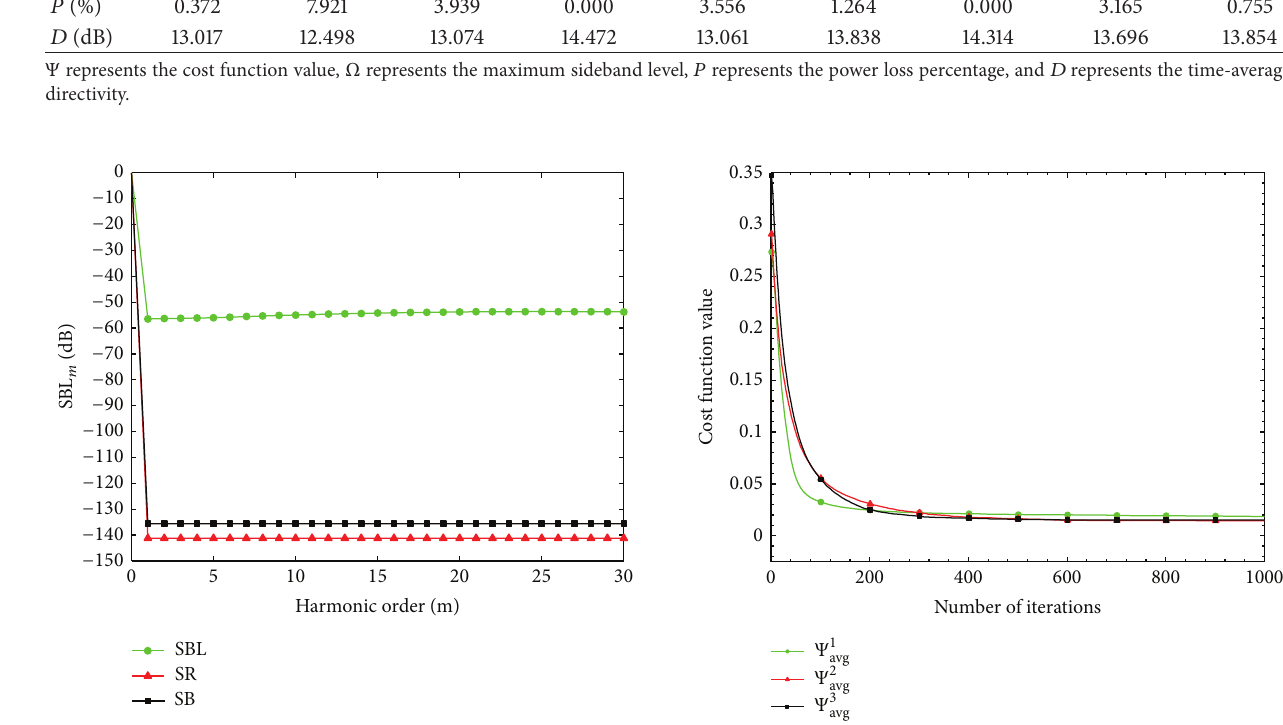
Figure 7: The first 30 maximum harmonic levels of best converged solution related to Figure 5 for IS.